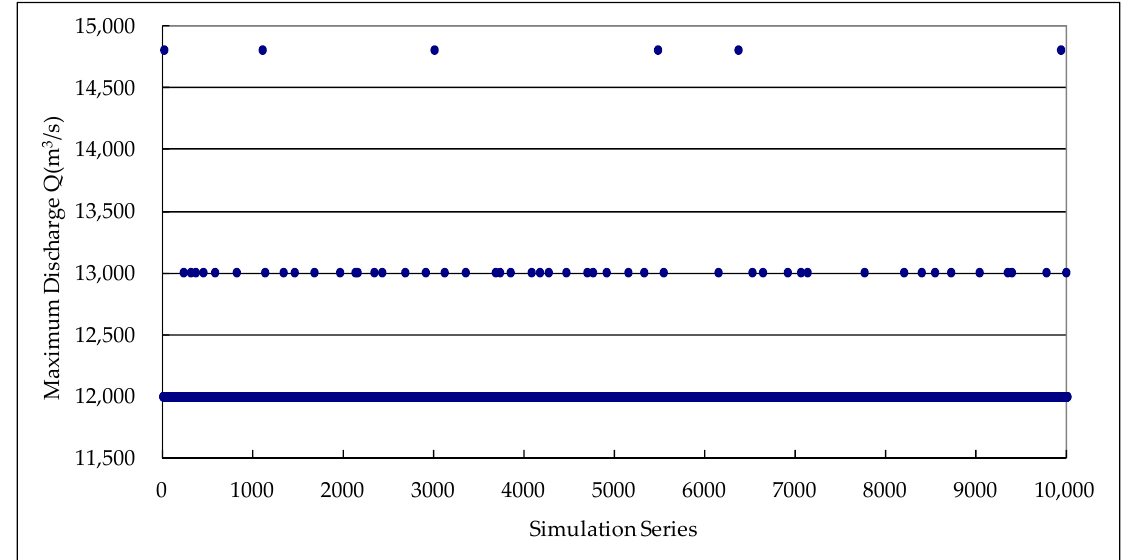
Figure 5. Maximum discharge distribution in 10,000 simulations for five-year flood based on CO.